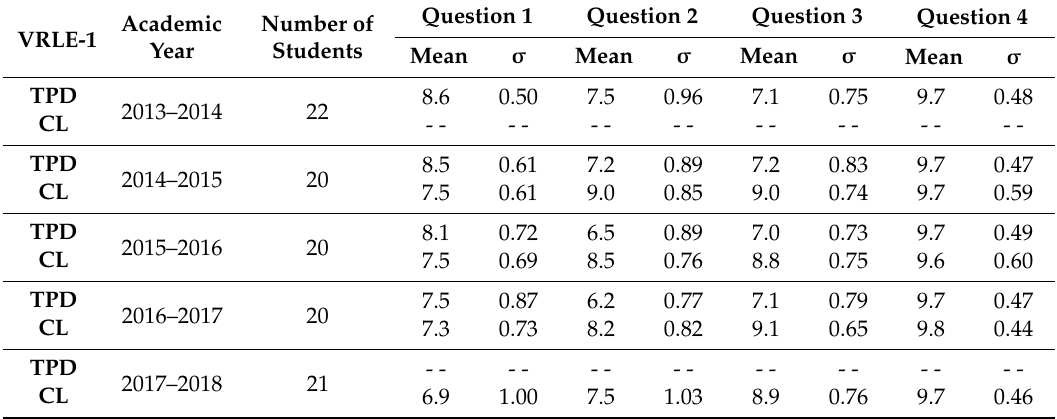
Table 2. Mean and standard deviation ( σ ) of students’ scores from surveys given from 2013 to 2017 to each question of the Table 1 for VRLEs developed formerly (VRLE-1, Figure 3).